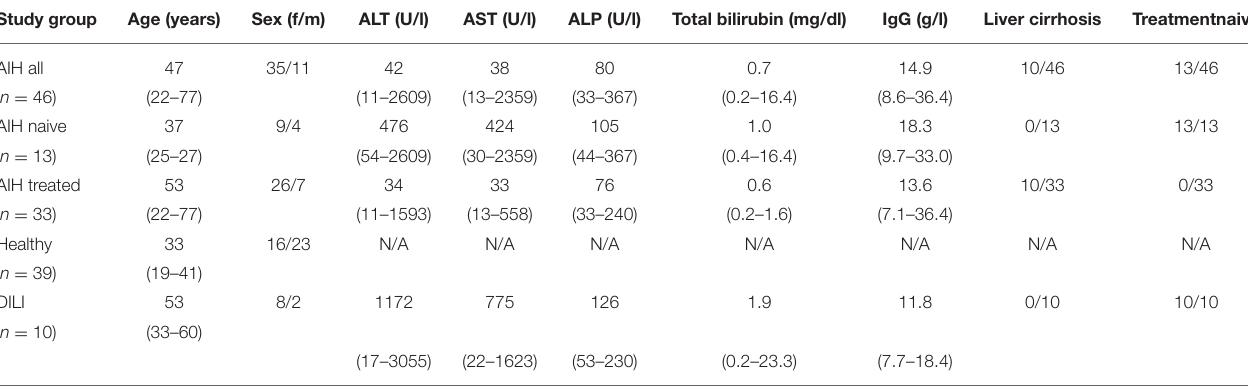
TABLE 1 | Clinical characteristics of AIH patients and control groups at the time of analyses of peripheral unconventional T cells. Study group